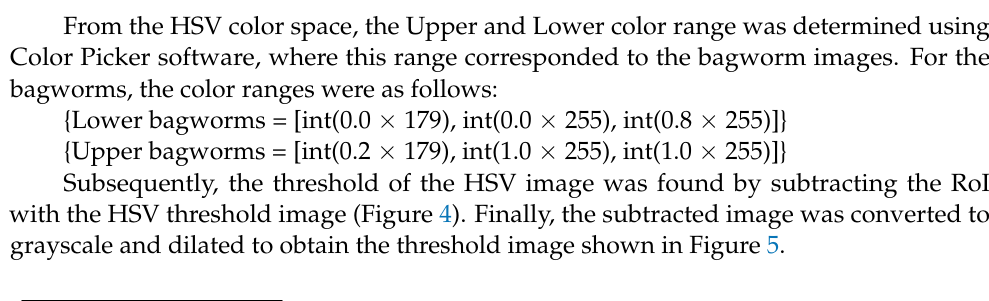
Figure 3. Color space conversion from RGB to HSV.